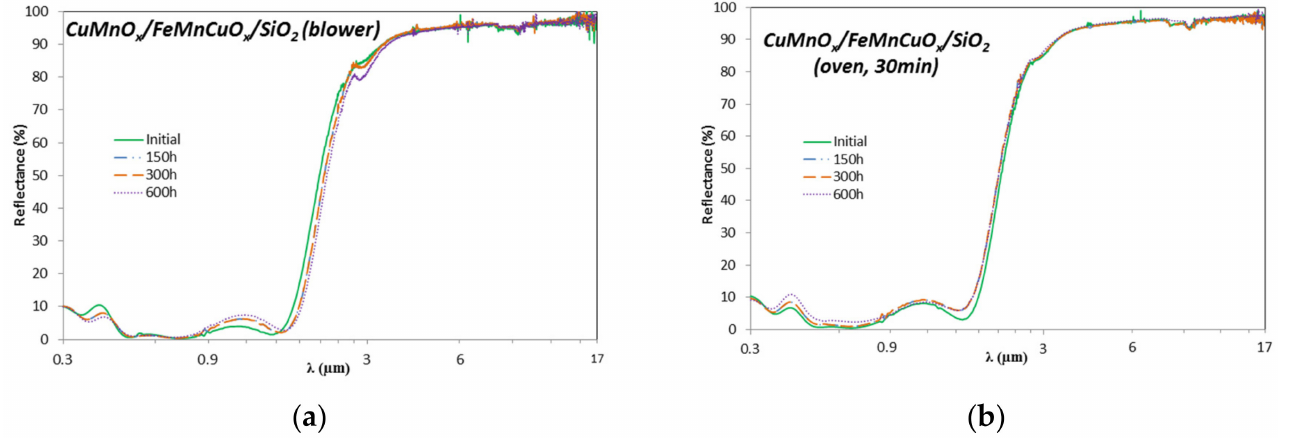
Figure 10. Variation of the hemispherical reflectance spectra for wavelengths from 0.3 to 17 µ m of Al/CuMnO x /CuFeMnO x /SiO 2 (blower) ( a ) and Al/CuMnO x /CuFeMnO x /SiO 2 (oven, 30 min) ( b ) samples before and after each ageing step in the condensation test.